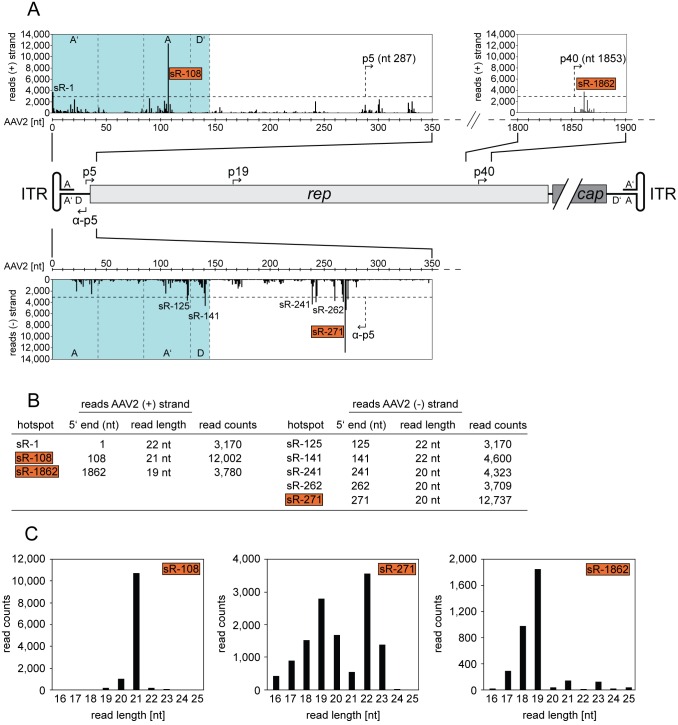
Small RNA-Seq: Detailed mapping of small AAV2-specific reads to both strands of the genome.(A) Detailed mapping of small AAV2-specific reads in regions of high read frequencies in AAV2/Ad2 co-infected cells from Fig 1A. A schematic representation of the AAV2 genome is displayed in the center. Read assignments to the (+) strand are presented above and to the (-) strand below the genome, with read counts displayed at single nucleotide level. A horizontal dashed line marks the threshold value set to 3,000 reads. Any small RNA (sR) above 3,000 read counts was defined as hotspot candidate, designated according to the 5’ starting nucleotide. Different genomic regions of the AAV2-ITRs (highlighted in turquoise) are separated by vertical dashed lines. Complementary regions of the hairpin-structured ITR are indicated by letters, e.g. A, A’; D, D’. Promoters on the AAV2 (+) or (-) strand are indicated by arrows. (B) Summary of small RNA hotspot candidates on the AAV2 genome, displayed in (A), designated according to their starting nucleotide (5’ end). Average read lengths are shown for the small RNAs. (C) Depicted are the detailed small RNA read length distributions for sR-108, sR-271 and sR-1862. Small RNA hotspots highlighted in red were validated further.